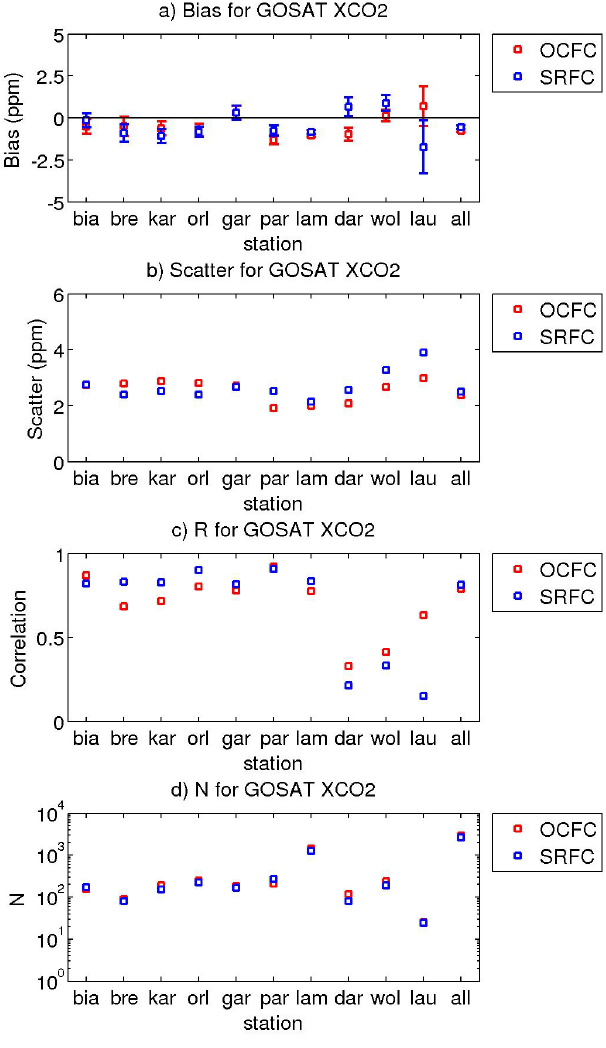
Figure 6. GOSAT XCO 2 bias (a) , scatter (b) , correlation (c) and number of data pairs (d) , for all individual TCCON stations and all data